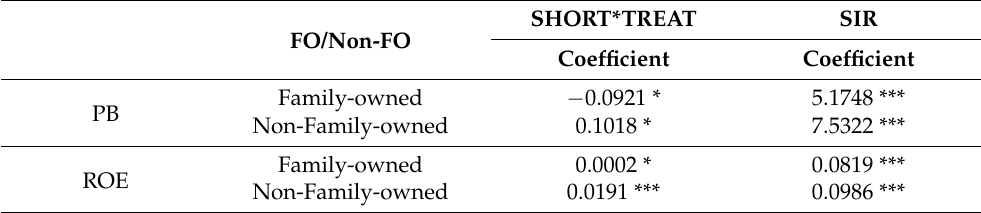
Table 10. Family ownership vs. non-family